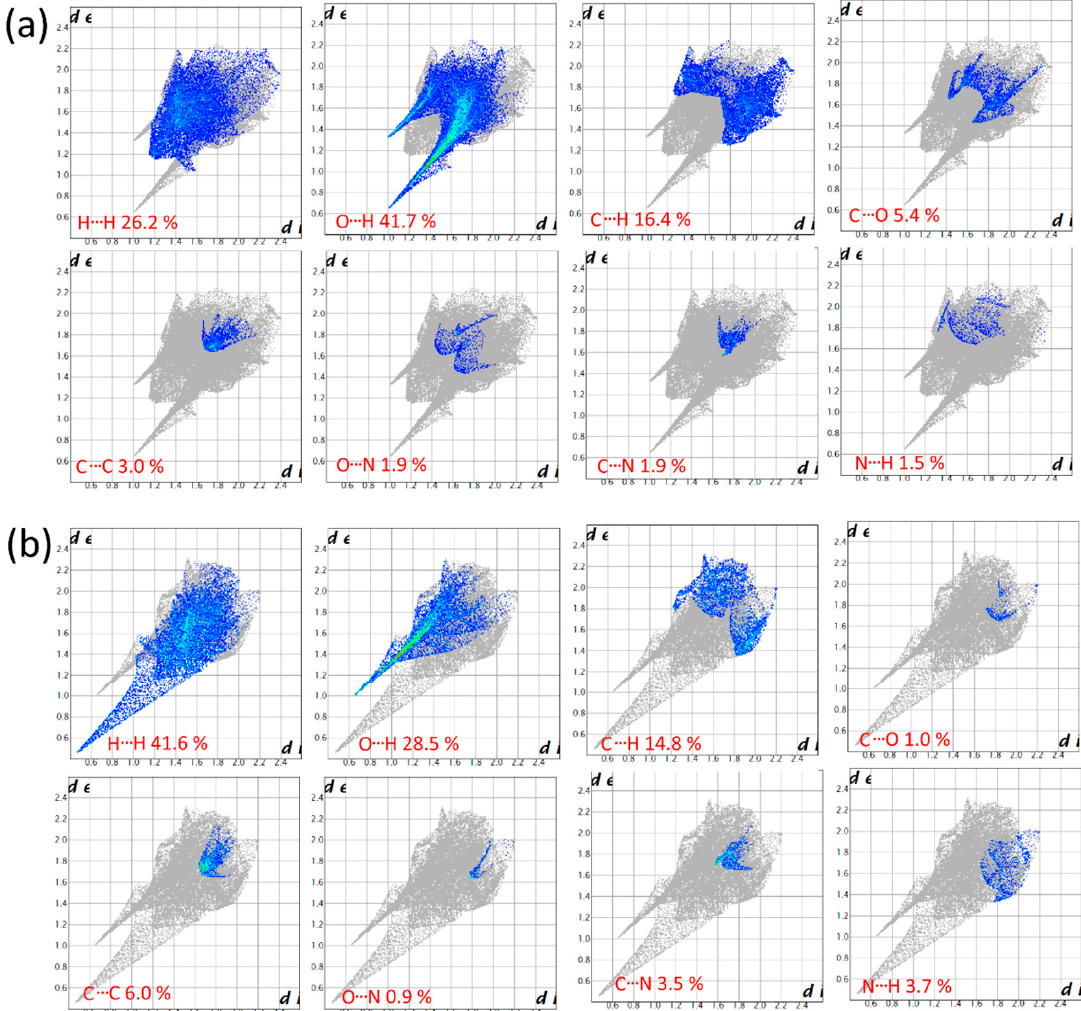
Figure 6. Fingerprint plots of cation and anion of IM + –NPG − –HYD , ( a ) IM + , and ( b ) NPG − : full (upper left) and resolved into different intermolecular interactions showing the percentages of interactions contributing to the total Hirshfeld surface area of the cation and anion in the salt hydrate. The x -axis and y -axis represent the values of d e (distance from the point to the nearest nucleus external to the surface) and d i (distance to the nearest nucleus internal to the surface).